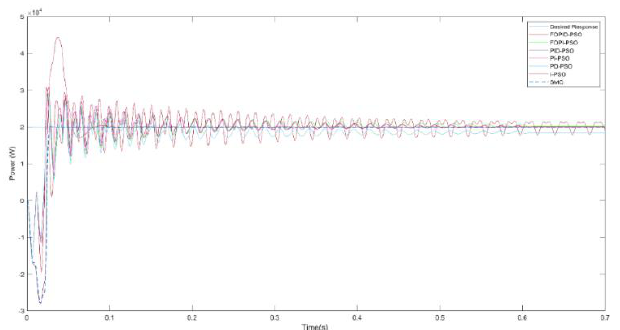
Fig. 23. The SMC is compared to all the optimal controllers using PSO